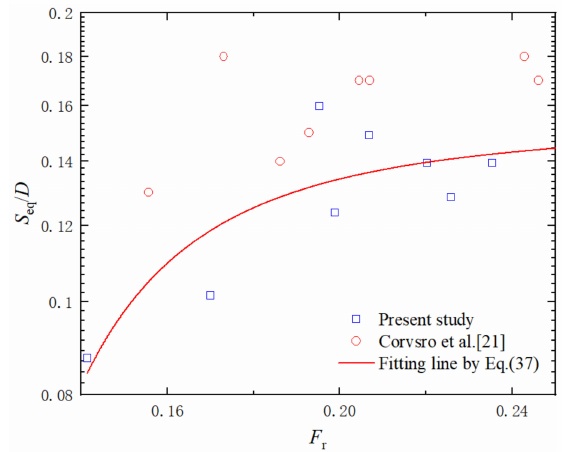
Figure 23. The fitting curve between S eq / D and F r .